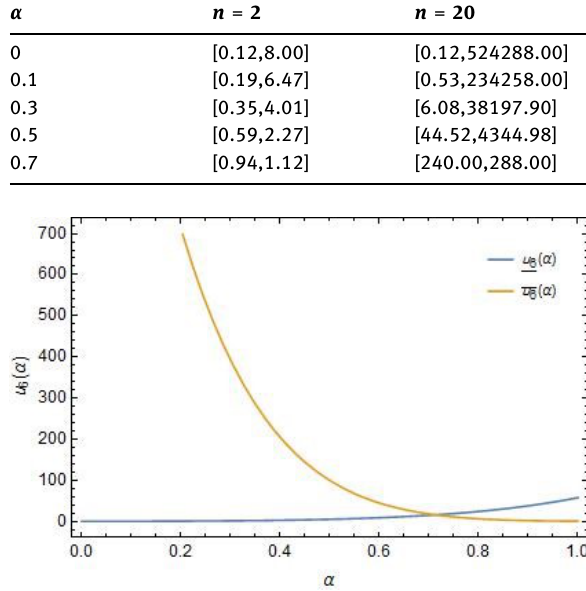
Fig. 7: Solution of u n ( α ) = ⌊ u n ( α ), ¯ u n ( α ) ⌋ for n = 6 of Example 5.2 for Type